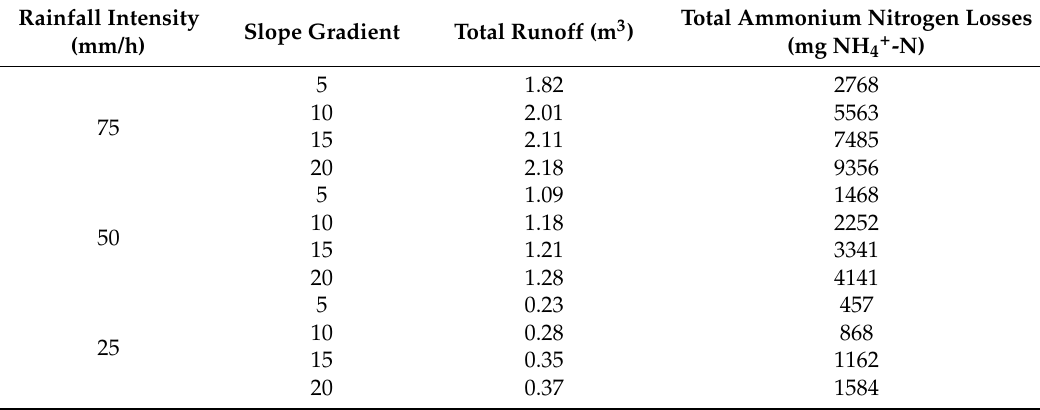
Table 2. The variation of total runoff and ammonium nitrogen losses under different rain intensities and slope gradients.